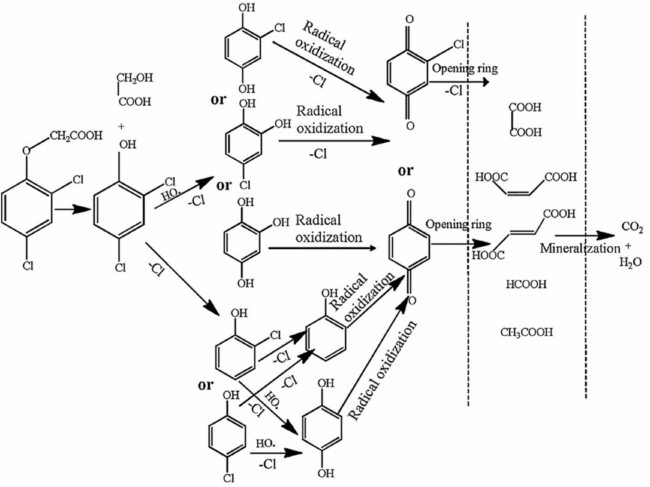
Figure 6. The proposed degradation pathway of 2,4-D